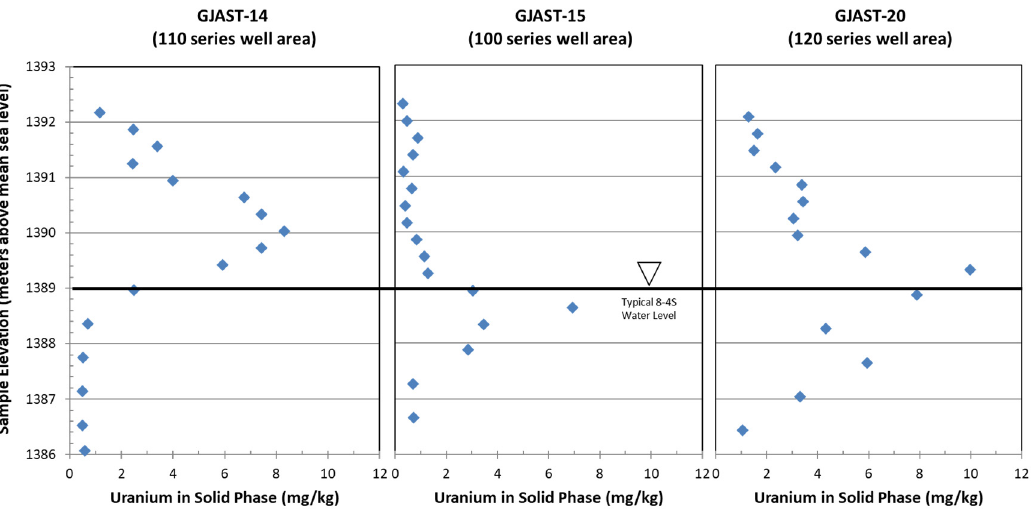
Figure 2. GJAST-14, -15 and -20 (locations in Figure 1) uranium concentrations with depth (National Geodetic Vertical Datum of 1929) for 5% nitric acid extraction. Typical water table for all three locations is 1389 m. Original data are from [1].